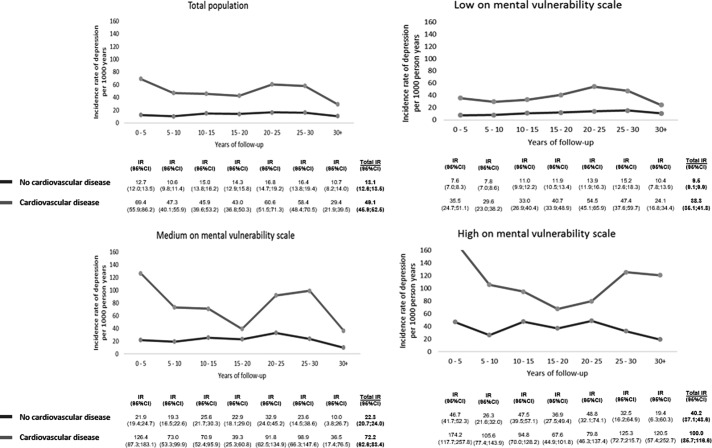
Crude incidence rates (IR) and 95% confidence intervals (95% CI) of depression in strata of individuals with low, moderate, and high mental vulnerabilities.